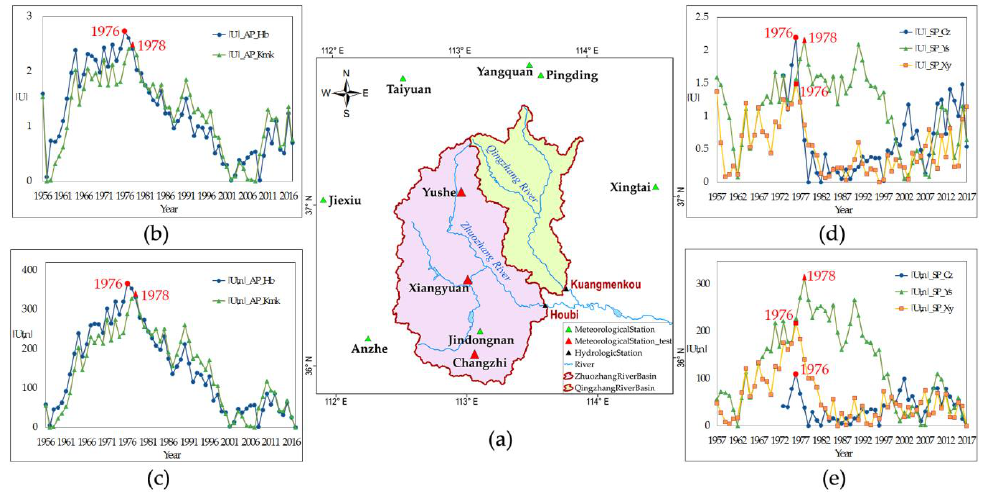
Figure 3. Variation analysis of annual area and station precipitation. ( a ) National meteorological stations selected and their distribution, in green and red. All have contributed to annual area rainfall calculation for two sub-basins ( b , c ), and three in red were also tested to analyze trends in the Zhuozhang River basin ( d , e ); ( b ) MRS test (|U|) for area precipitation (1956–2017) of Houbi(|U|_AP_Hb) and Kuangmenkou(|U|_AP_Kmk); ( c ) Pettitt test (|U t , n |) for area precipitation of two sub-basins during the same period; ( d ) MRS test for station precipitation of Changzhi (|U|_SP_Cz 1973–2017) at south source, Yushe (|U|_SP_Ys 1957–2017) at north source, and Xiangyuan (|U|_SP_Xy 1957–2017) at the